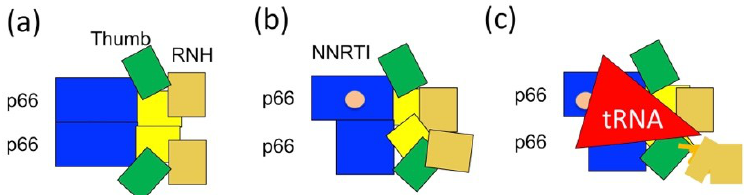
Figure 6. Our current model for p66 / p51 production from p66 / p66: ( a ) symmetric p66 / p66 conformation in which thumb and RNH domains undergo domain motion; ( b ) asymmetric p66 / p66 bound to NNRTI; and ( c ) conformational change induced by tRNA Lys3 interaction, regardless of the presence of NNRTI or not [40,100,124]. Note the degrees of conformational asymmetry in ( b , c ) are hypothetical.